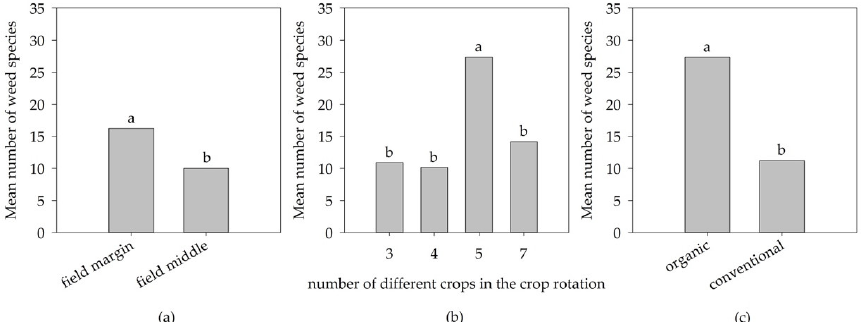
Figure 2. Factors influencing the mean number of weed species in the Swabian Alps ( a ) location in the field; ( b ) number of different crops in the crop rotation; and ( c ) farming system. Means with different letters represent significant differences according to the Tukey HSD test ( p ≤ 0.05).